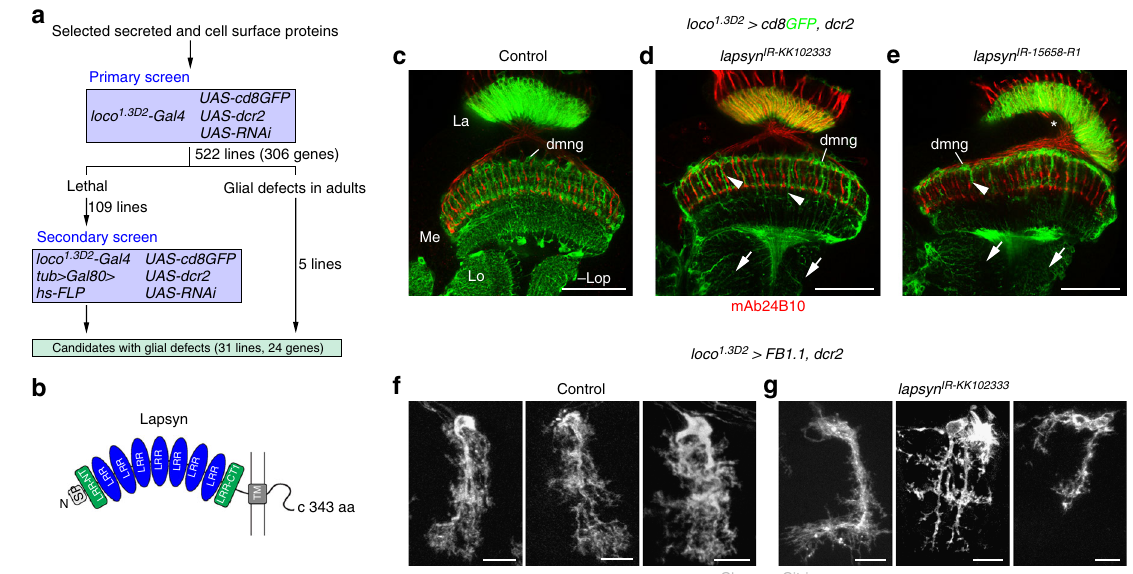
Fig. 3 A RNA interference screen for factors mediating glial branch morphogenesis. a Schematic representation of screen strategy. To knockdown genes that encode selected secreted and cell surface molecules, UAS-RNAi and UAS-dcr2 were expressed in astrocyte-like glia under the control of loco 1.3D2 -Gal4 . A secondary screen was performed for UAS-RNAi lines causing early lethality. To achieve mosaic expression of UAS-RNAi transgenes in astrocyte-like glia using loco 1.3D2 -Gal4 , a heat shock -FLP ( hs-FLP ) recombinase transgene was induced transiently to promote the random excision of the FRT site fl anked Gal4-repressor Gal80 encoding cDNA downstream of the widely active tubulin enhancer (tub > Gal80 > ) 68 . b Lapsyn encodes a transmembrane (TM) cell adhesion protein containing seven leucine-rich repeat (LRR) domains fl anked by N-terminal LRR-NT and C-terminal LRR-CT1domains. SP signal peptide. c – e loco 1.3D2 -Gal4 drives expression of UAS-cd8GFP , UAS-dcr2 , and two independent RNAi constructs, UAS-lapsyn IR-KK102333 and UAS-lapsyn IR-15658-R1 . f , g loco 1.3D2 -Gal4 drives expression of UAS-FB1.1 ( white ) in controls ( f ) and UAS-lapsyn IR-KK102333 , UAS-dcr2 in lapsyn knockdown animals ( g ). La